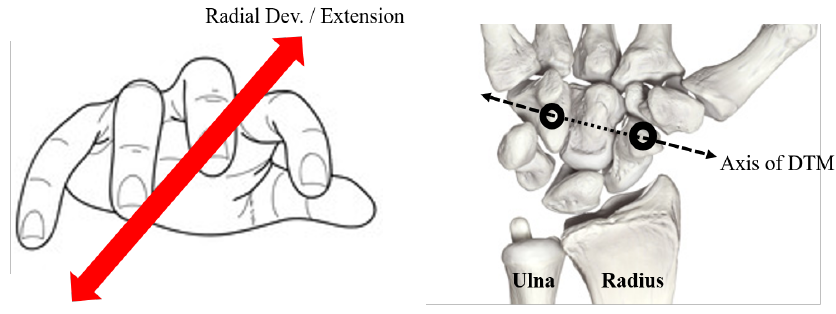
Figure 5. Schematic drawing showing the orientation of the DTM axis.